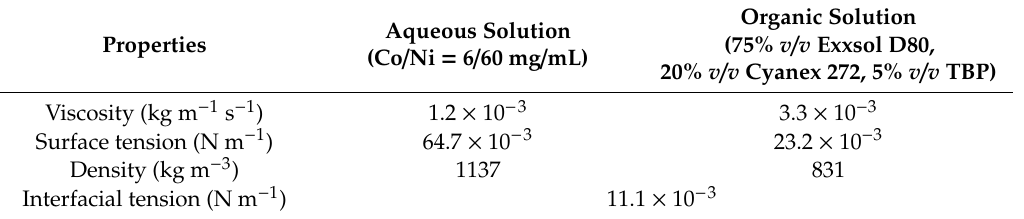
Table 2. Properties of the aqueous and organic phases.